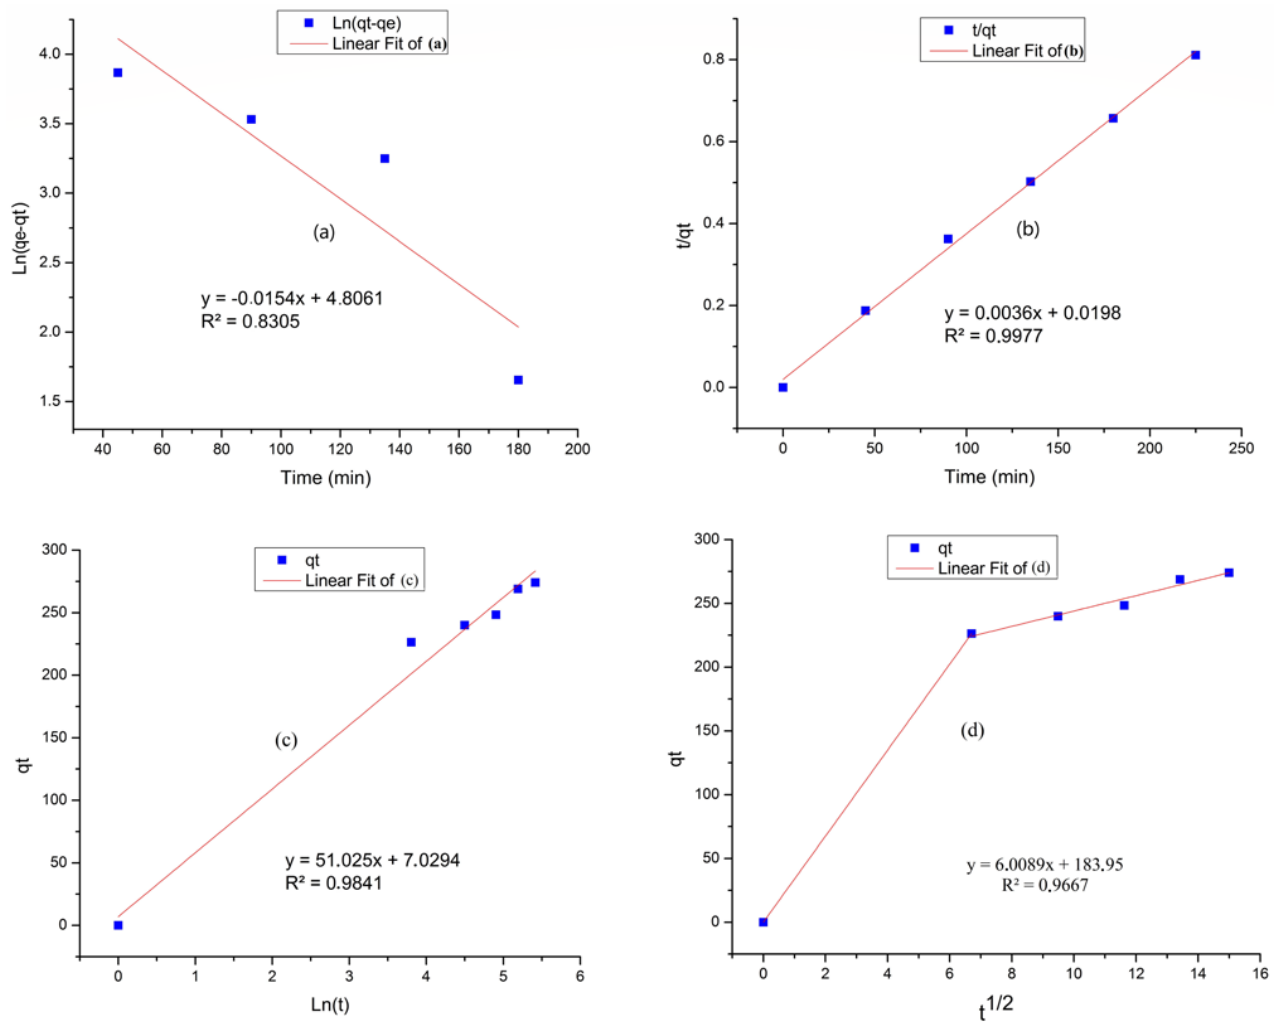
Figure 7. Kinetics curves for the TA adsorption by SS: ( a – c ) pseudo-first-order, pseudo-second-order and Elovich kinetics fitting, respectively, and ( d ) intraparticle diffusion model. Adsorption conditions: pH = 6.6; T = 293 K; time = 225 min. Table 5. Fitting parameters of TA adsorption to SS following pseudo-first-order, pseudo-second-order, Elovich kinetics, and Intraparticle diffusion